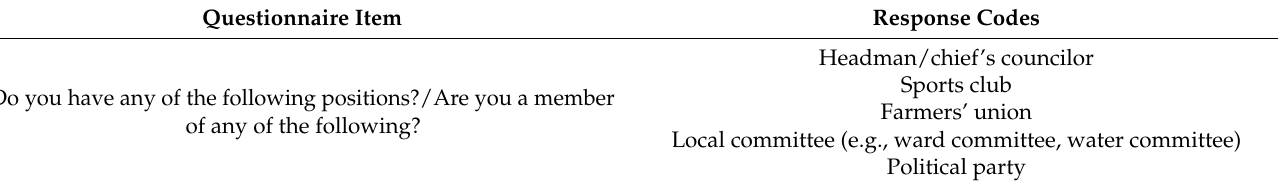
Table 2. Inventory used for the measurement of social capital.